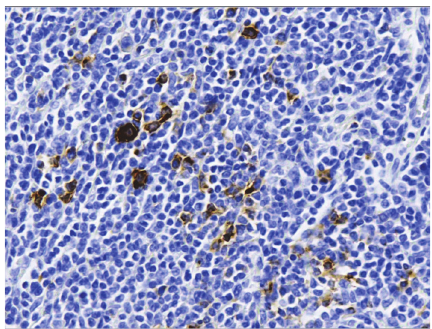
Figure 2: Follicle bulb onion, typical of Castleman disease. Stained section of lymph node biopsy, × 100 magnification, HES coloration.